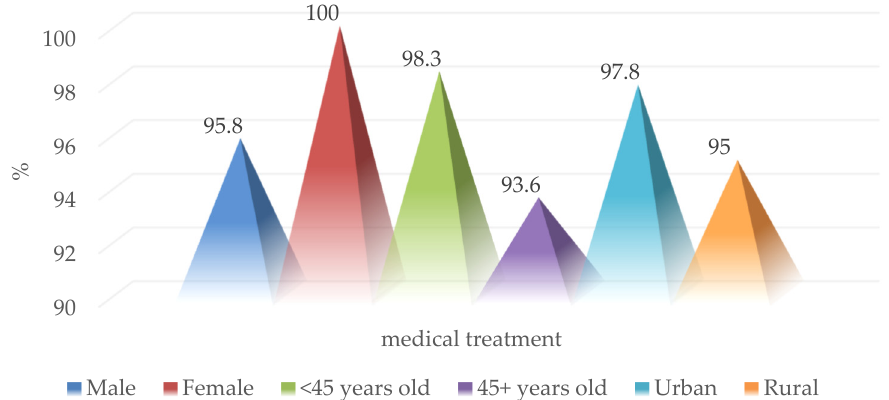
Figure 14. Epidemiological characteristics of patients who received medical treatment.